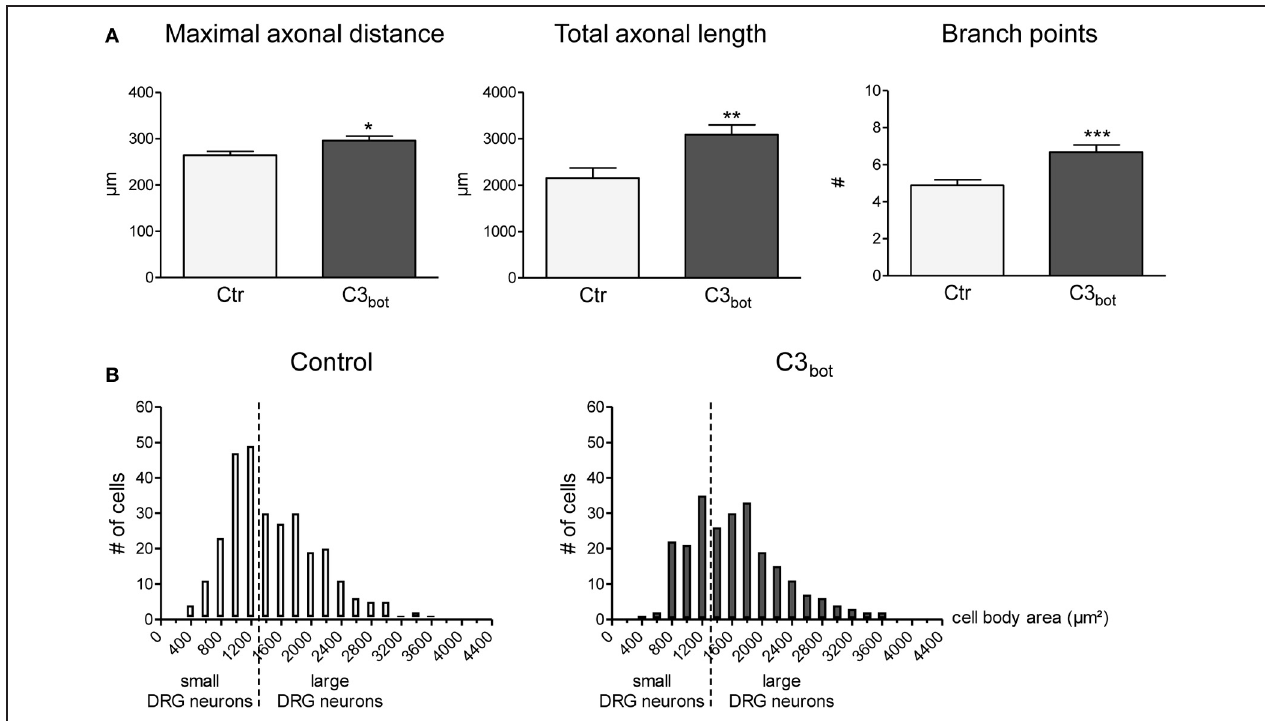
FIGURE 2 | Application of the Rho inhibitor C3 bot (1 μ g/ml, membrane permeable) for 24h increases the length of the longest axon (maximal axonal distance), the extension of the axonal tree (total axonal length), and the number of branch points per neuron ( A ; total number of neurons per group > 240, three independent experiments,